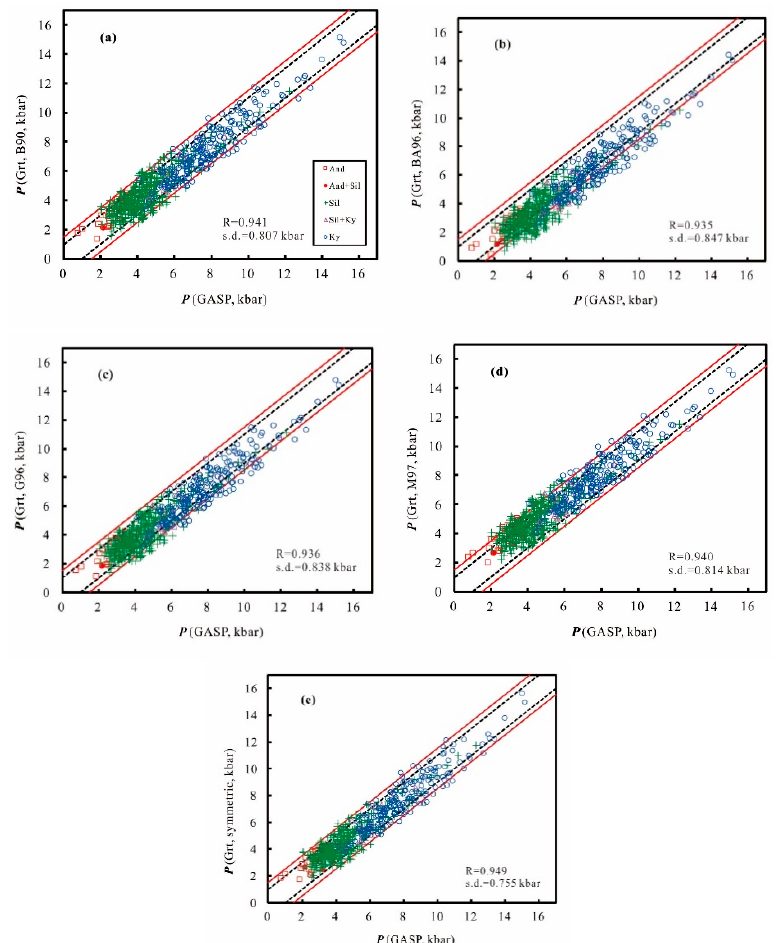
Figure 6. The GASP [49] versus garnet pressures calibrated by different activity models of garnet. The dashed black and solid red lines define ±1.0 kbar and ±1.5 kbar deviations, respectively. R, multiple correlation coefficient; s.d., standard error. ( a ) Activity model of [61]; ( b ) activity model of [62]; ( c ) activity model of [63]; ( d ) activity model of [64]; and ( e ) symmetric quaternary activity model with all Margules parameters derived in this work.